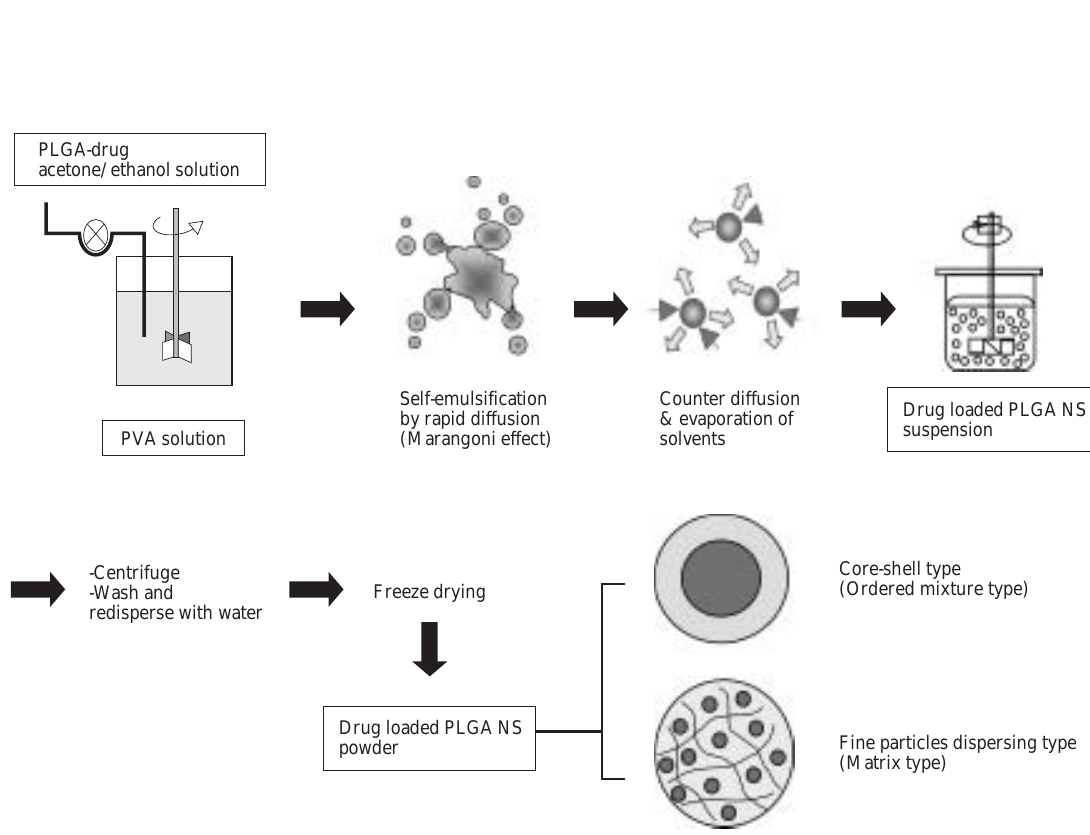
Fig. 5 Process for production of drug encapsulated PLGA NS (nanospheres) by the spherical crystallization